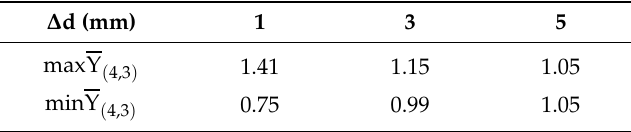
Table 2. Average Y ( 4,3 ) over ∆ Table 2. Average 𝚼 ((cid:2872),(cid:2871)) over Δ d.